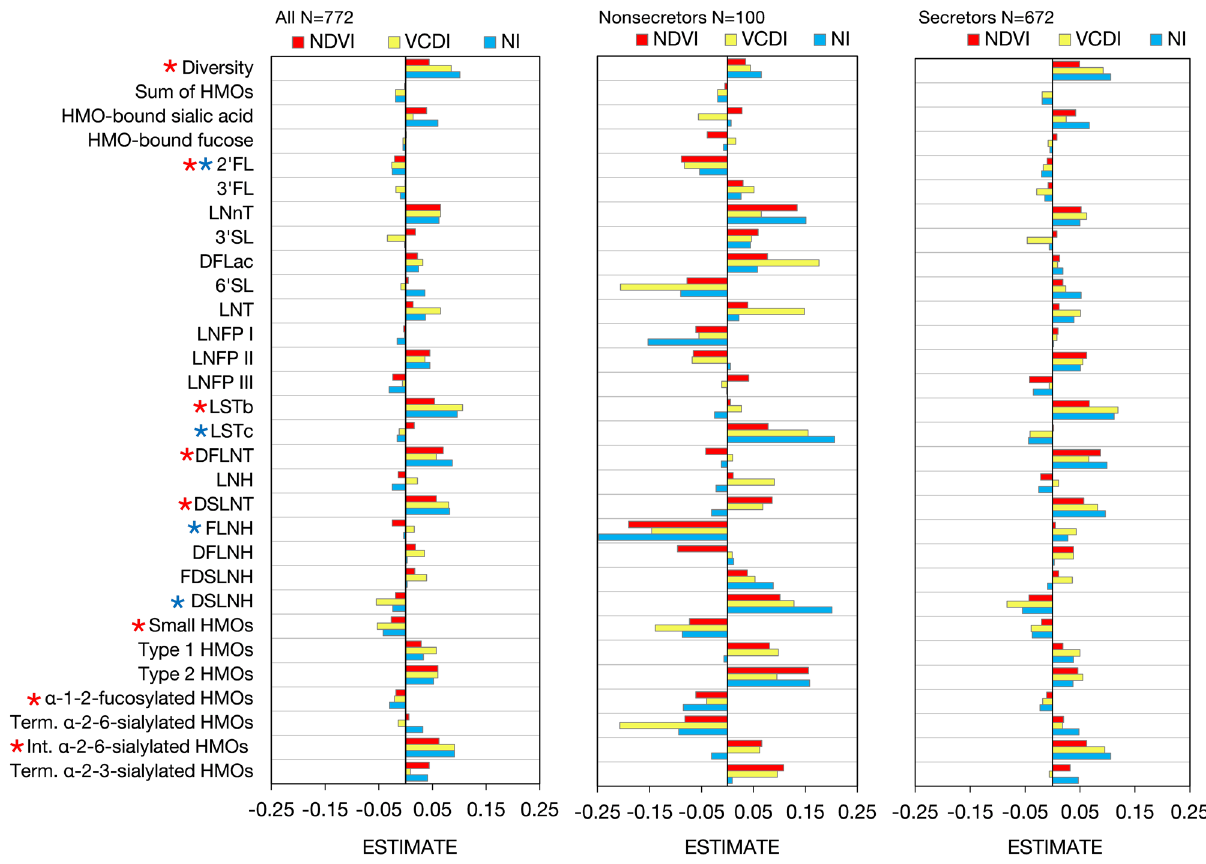
Figure 1. Associations between residential green environment and HMO diversity, individual HMO concentrations and HMO structural groups (750 m × 750 m grids). Figures are plotted separately for all (estimates from main effects, Table 2), and non-secretors and secretors (estimates from interactions, Suppl. Table 3a–c). Size of the bar shows the strength of the association and negative and positive values the direction of the association by standardized estimates. Red stars indicate ≥ 2/3 of the main associations with the HMO component and the three residential green environment variables were significant, and blue stars that ≥ 2/3 of the interactions between the residential green environment variables and secretor status being significant i.e. associations with residential green environment on HMO component concentration differ by secretor status. Term., terminal; Int.,